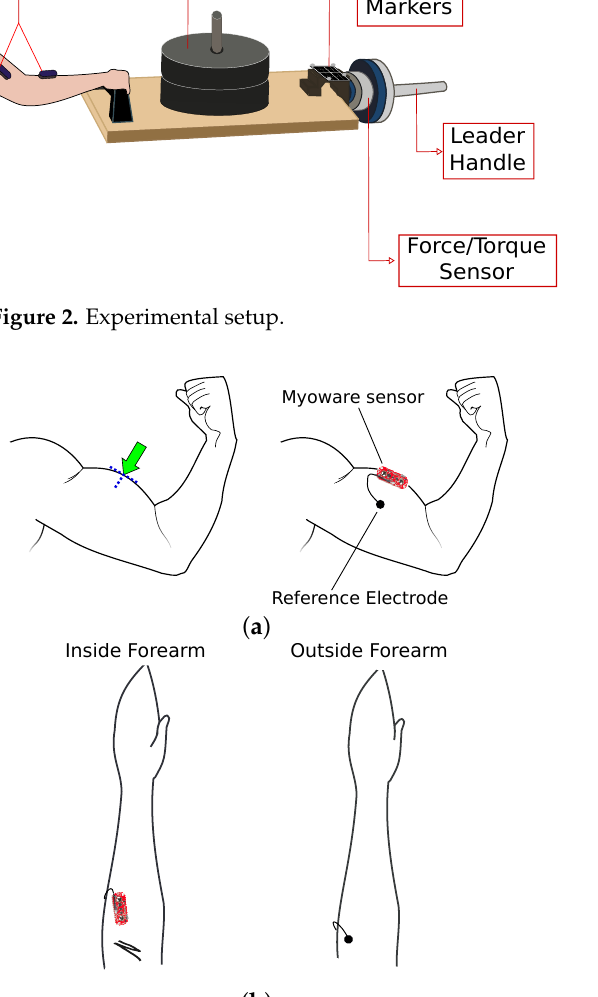
Figure 3. Fitting sEMG (Surface electromyography) sensors on ( a ) biceps and ( b )